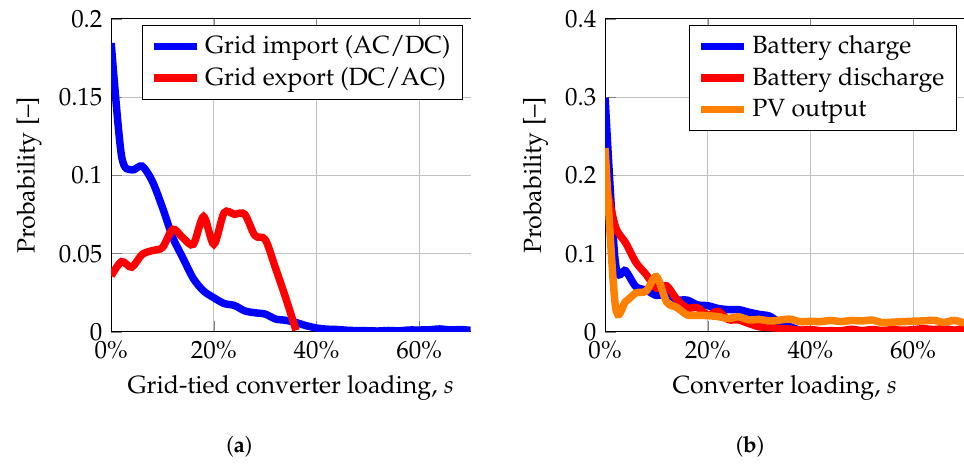
Figure 9. Power flow distribution in annual operation for ( a ) grid import and export, and ( b ) battery charge and discharge, and PV